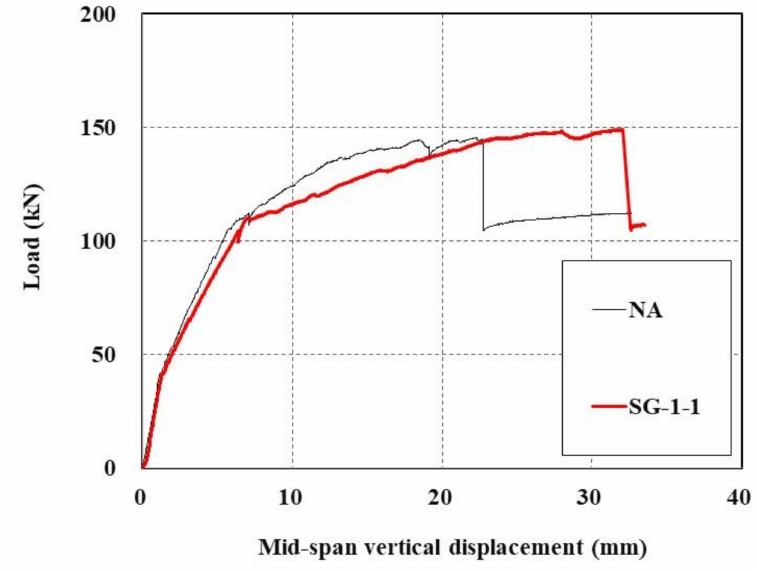
Figure 16. Load-displacement curves of TRC-strengthened RC slab with (SG-1-1) and without anchors